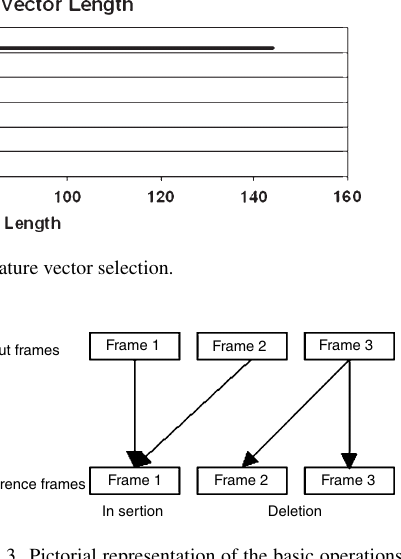
Fig. 3. Pictorial representation of the basic operations of Dynamic Time